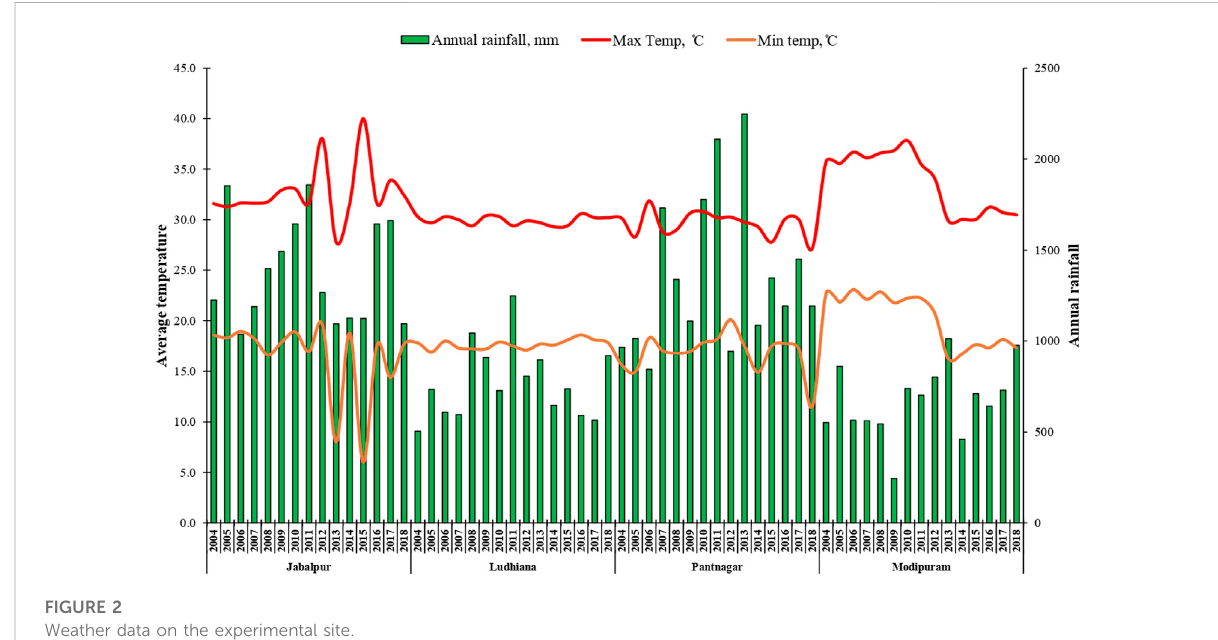
FIGURE 2 Weather data on the experimental